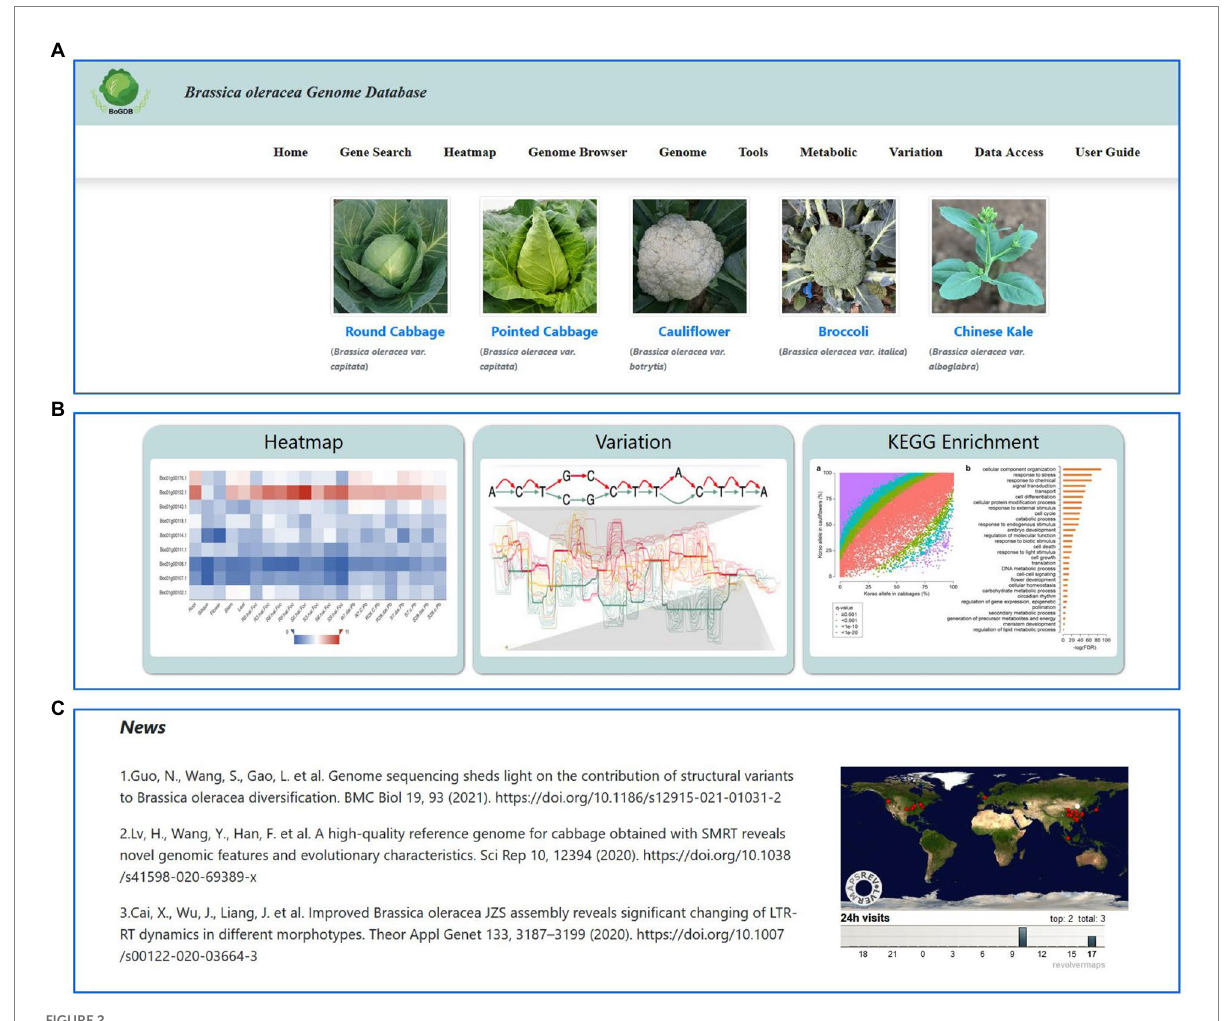
FIGURE 2 The homepage of BoGDB. (A) Navigation bar and species atlas. (B) Commonly used tool set. (C) News, citations, and global